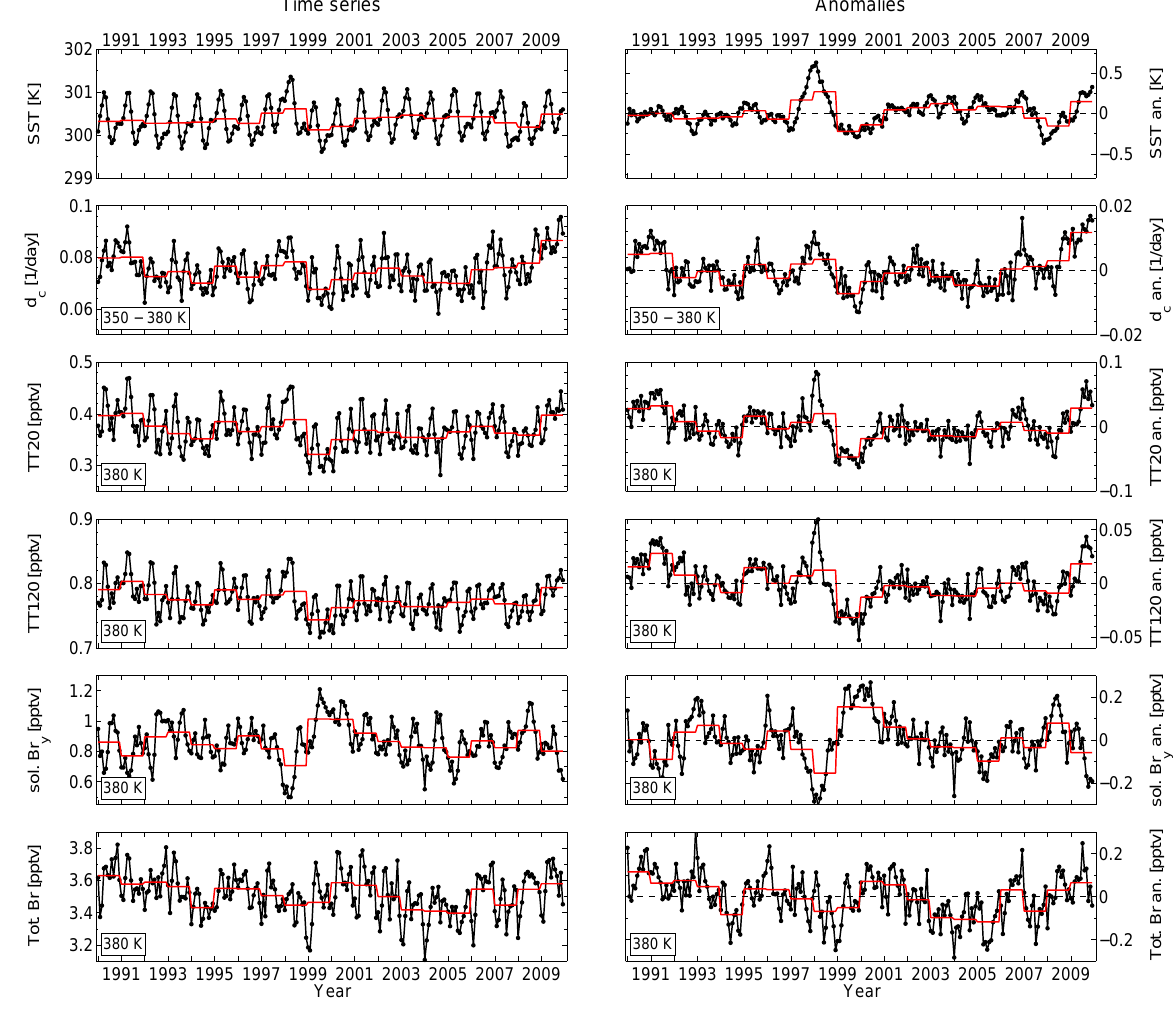
Fig. 8. Timeseries of monthly mean sea surface temperature SST, detrainment rate d c , idealized bromoform tracer TT20, idealized dibro- momethane tracer TT120, soluble Br y and total bromine (left panels) and the corresponding anomalies (right panels) from 1990 to 2009 averaged over the tropics (20 ◦ N to 20 ◦ S) at an altitude of approximately 17km (380K) for the tracers. The values for d c are an average of the range between the level of zero radiative heating and the cold point (350–380K). The red lines denote the corresponding yearly